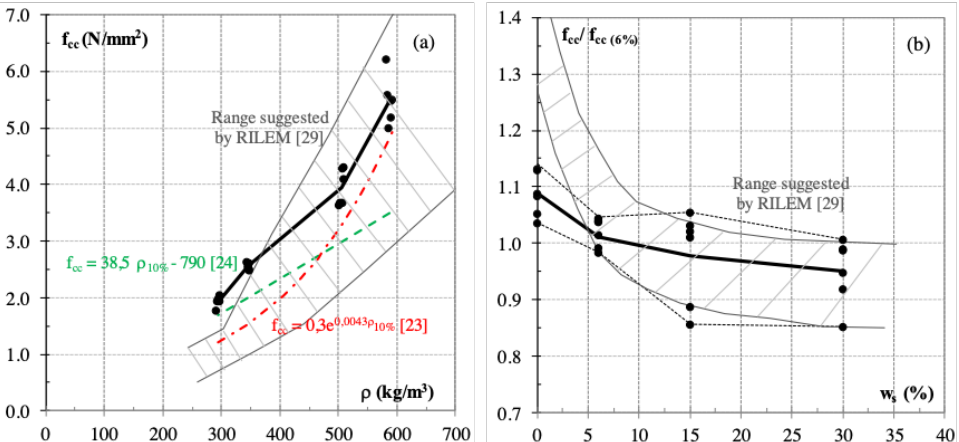
Figure 4. Comparison between experimental data and analytical relations available in the literature: a) cube compressive strength f cc vs. density ρ ; b) dimensionless cube compressive strength f cc /f cc (6%) vs. moisture content w s .